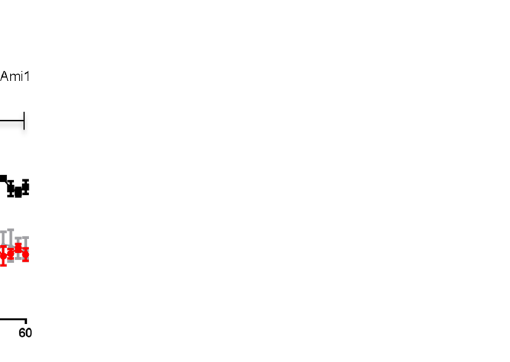
Figure 8. Assessment of cell wall permeability in the Δ ami1 mutant. Permeability of the mycobacterial cell wall was monitored by quantifying ethidium bromide diffusion into cells over time. The increased fluorescence observed for the Δ ami1 strain pointed to enhanced ethidium bromide uptake. Data represent three independent experiments where the error bars represented the standard error of the mean. *** p < 0.0001 for both parametric and non-parametric student’s T-test at all points